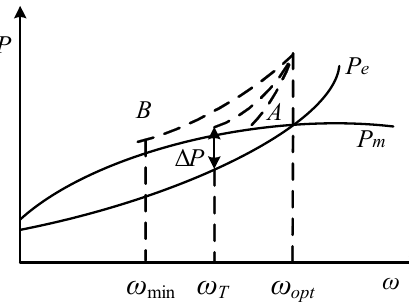
Figure 2. The relationship between rotor speed and output power of DFIG.